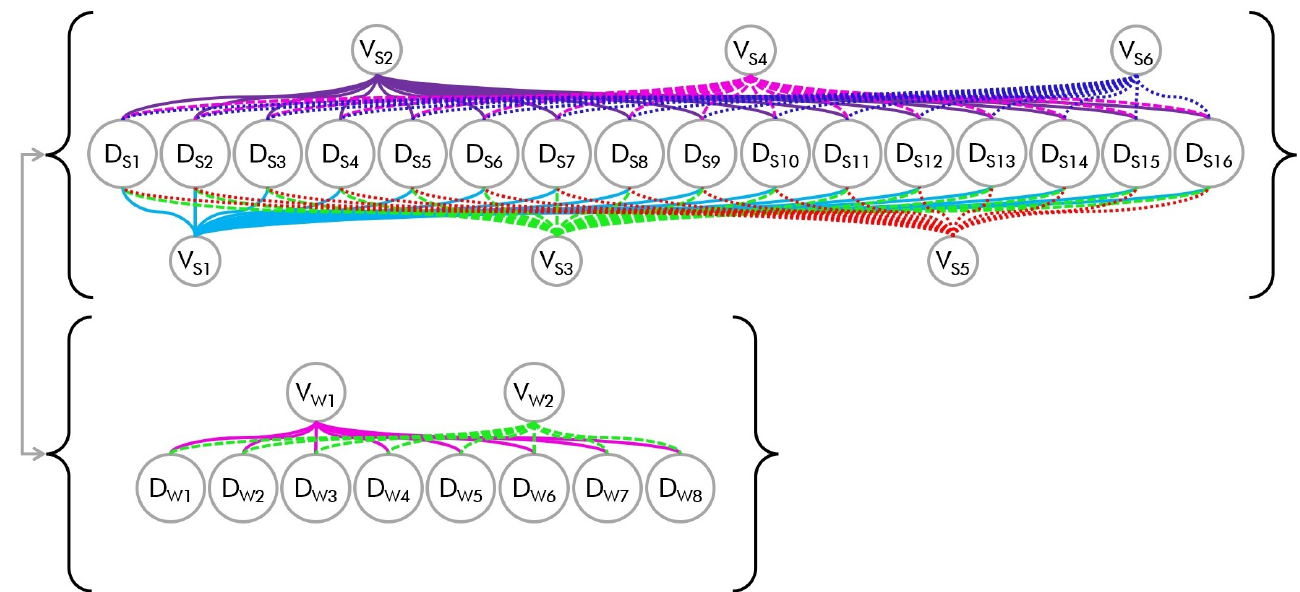
Figure 2. The structure of the synthetic SAR dataset for each class (for a single incidence angle θ r ) with a cross combination of ship velocities V s , the ship heading directions D s , wind velocities V w , and wind directions D w , with 1536 combinations overall. The values are given in Table 1 and in the text.